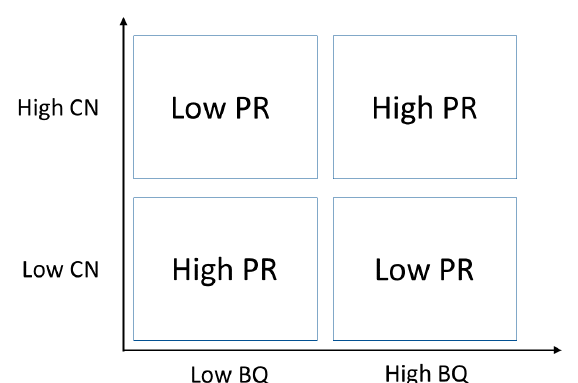
Figure 6. Hypothesized model where perceived restorativeness (PR) is the product of an individual’s connection to Nature (CN) and the biophilic quality of the environment (BQ). A subject’s perceived restorativeness is only high when he/she is exposed to an environment characterized by biophilic quality that exactly fits his/her own level of connection to nature.